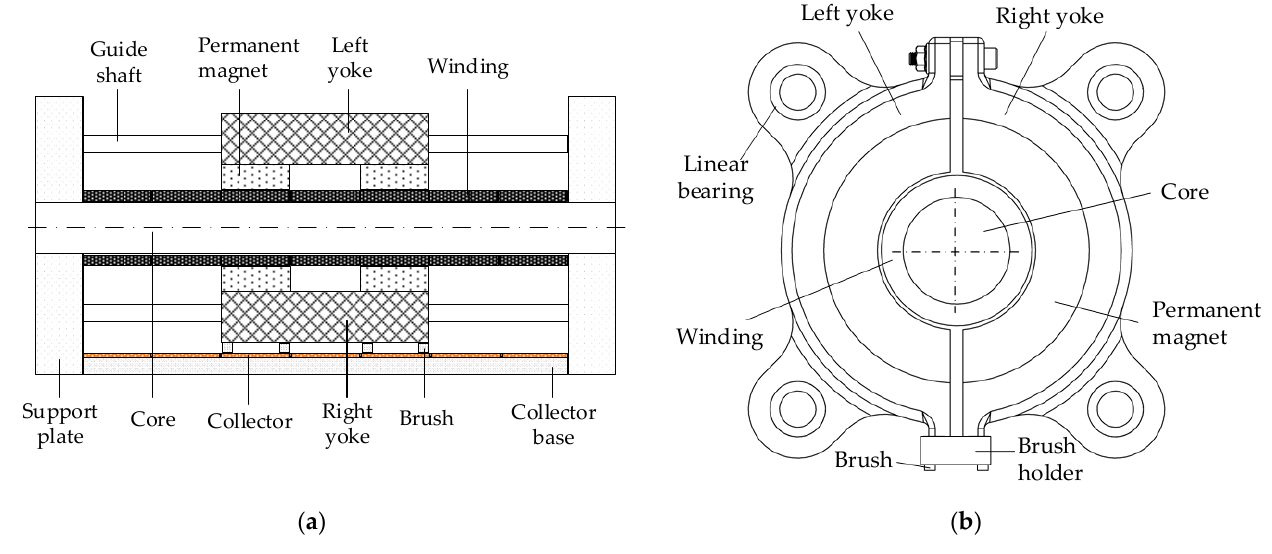
Figure 2. 3D geometrical structure of the CDCLM.